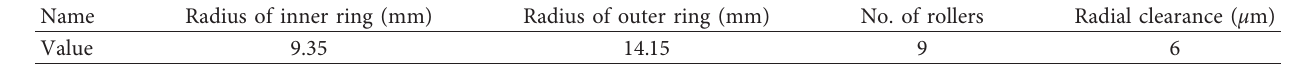
Table 8: Parameters of the intermediate